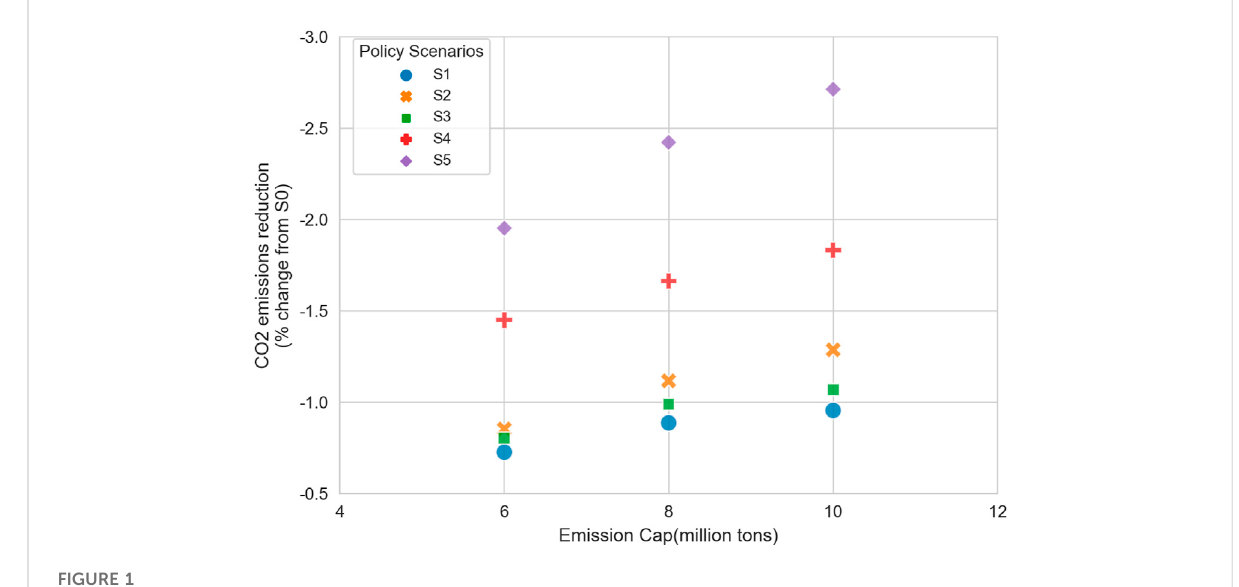
FIGURE 1 CO 2 emissions under different policy scenarios.